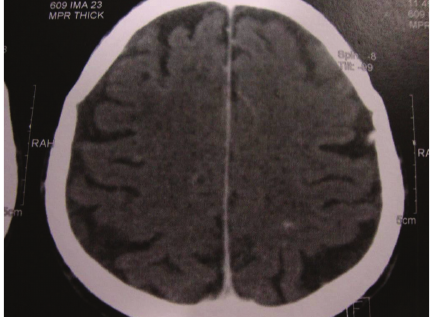
Figure 1: Axial MRI of the brain showing diffuse lesions mimicking secondary tumours.